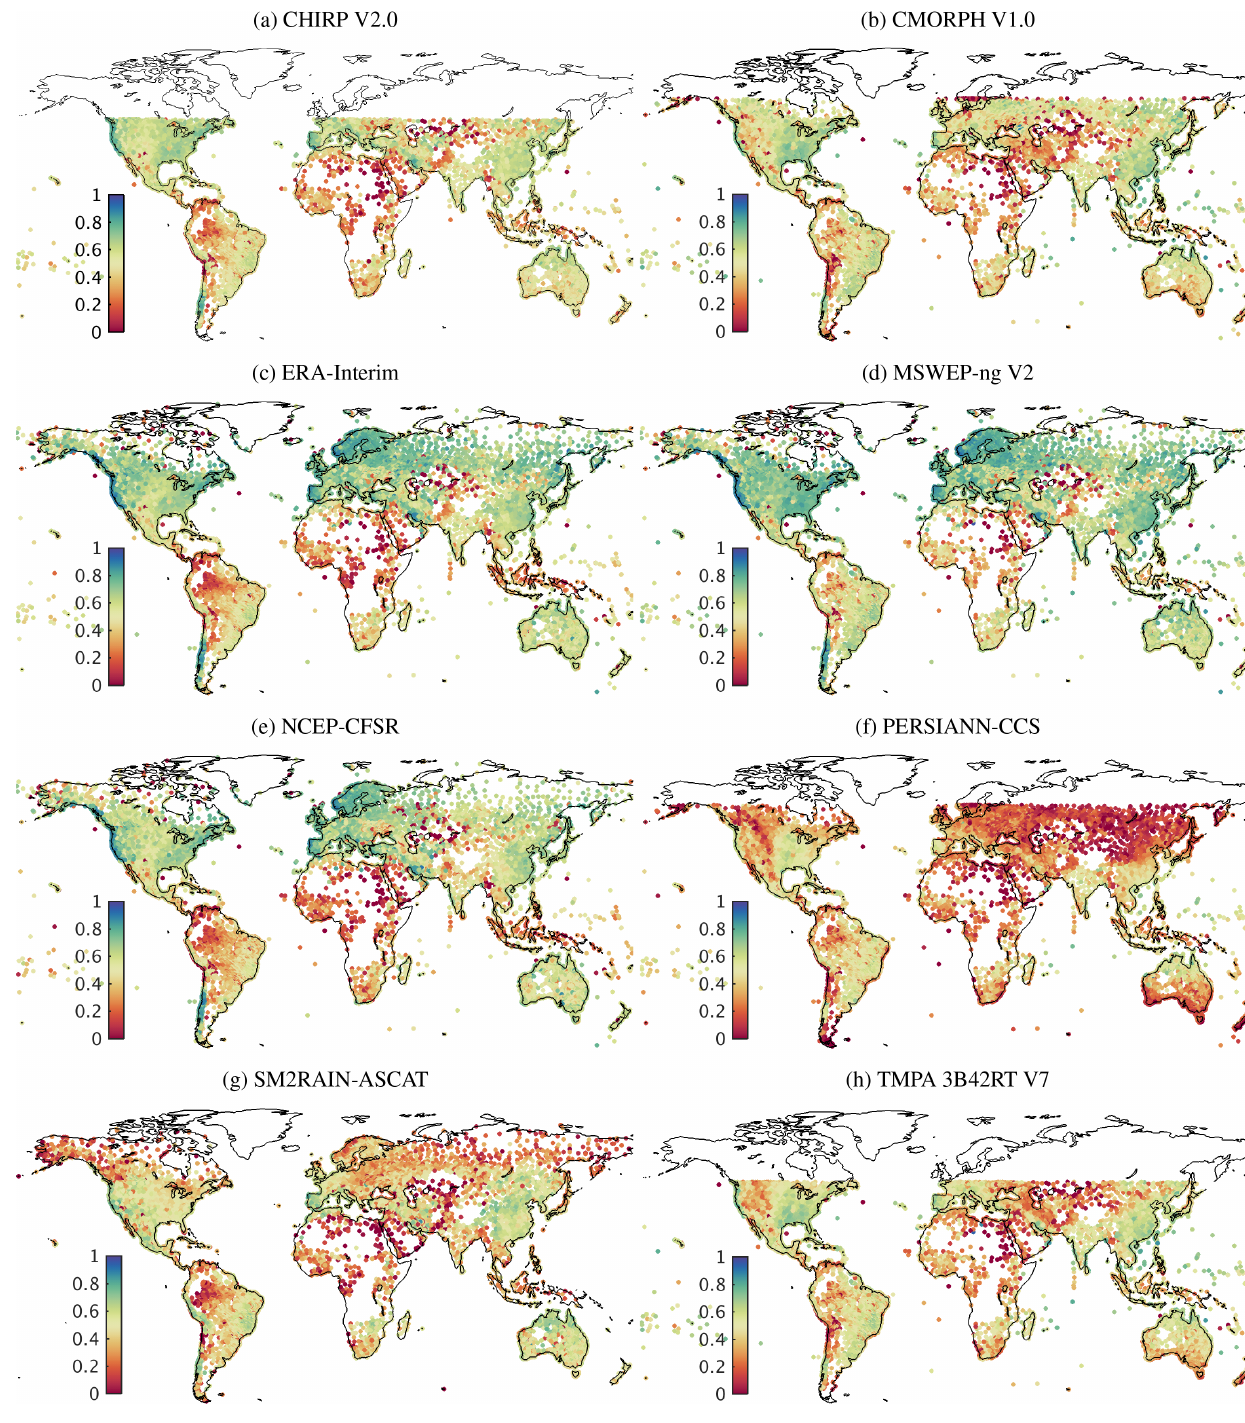
Figure 1. For a selection of the evaluated uncorrected P datasets, temporal correlations between 3-day mean gauge- and dataset-based P time series ( R 3 day ). Each data point represents a gauge. See the Supplement for global maps of the other performance